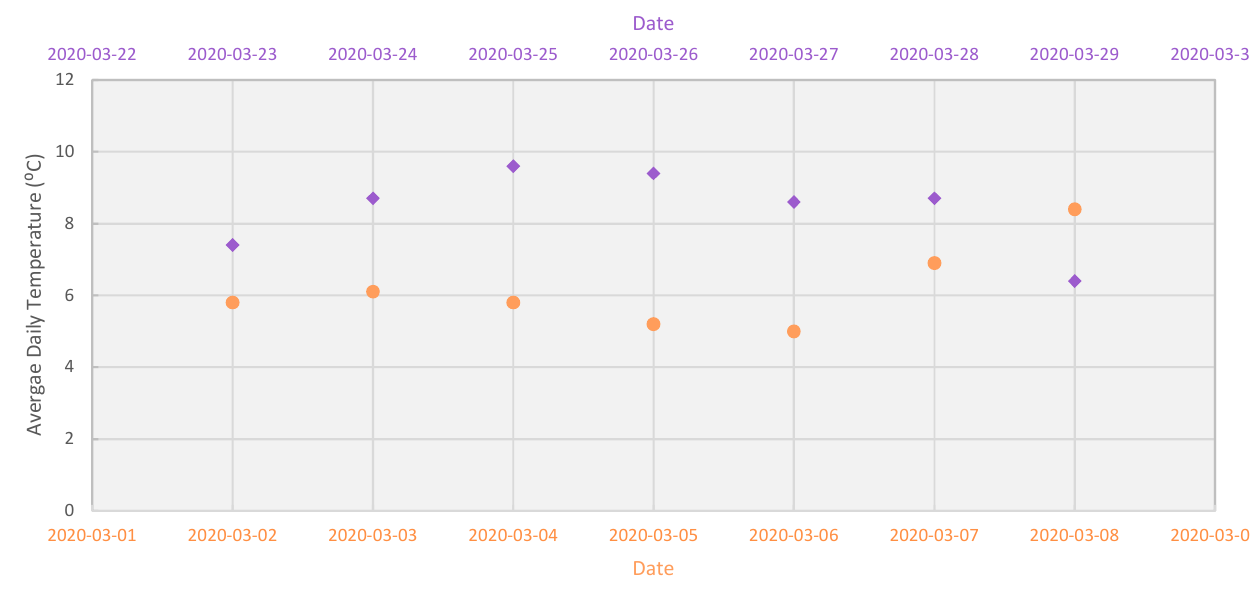
Figure 3. Average temperature data in Britain for before (w/c 02/03/20) and after (w/c 23/03/20) the lockdown. The aver- age difference between the pre- and post-lockdown weeks is 2.2 ◦ C.